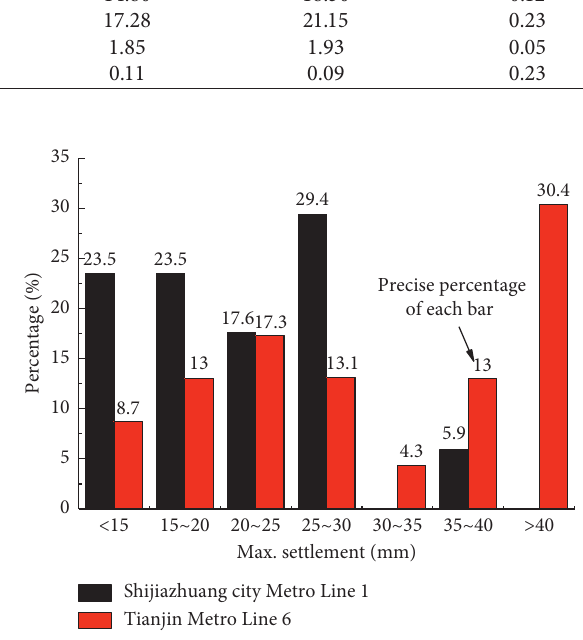
Figure 3: Distribution of maximum ground surface settlement behind retaining structures.